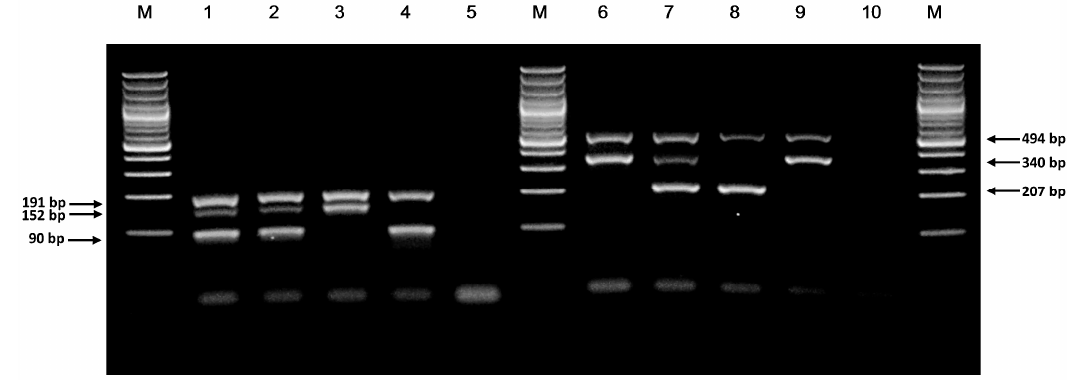
Figure 1. Genotyping of NUDT15 c.415C>T and TPMT*3C variants by ARMS-PCR. Lane M, GeneRuler 100 bp DNA Ladder (#SM0241, Thermo Fisher); lane 1, anonymized patient sample 17C-5685946 for NUDT15 c.415C>T genotyping (compatible with heterozygous genotype); lane 2, NUDT15 ARMS-PCR heterozygous (C/T) sample; lane 3, NUDT15 ARMS-PCR homozygous mutant (T/T) sample; lane 4, NUDT15 ARMS-PCR homozygous wildtype (C/C) sample; lane 5, NUDT15 ARMS-PCR no DNA control; lane 6, sample for TPMT*3C from same patient as lane 1 (compatible with homozygous wildtype genotype); lane 7, TPMT ARMS-PCR heterozygous (A/G) sample; lane 8, TPMT ARMS-PCR synthetic DNA fragment for G allele (G/G); lane 9, TPMT ARMS-PCR homozygous wildtype (A/A) sample; lane 10, TPMT ARMS-PCR no DNA control.